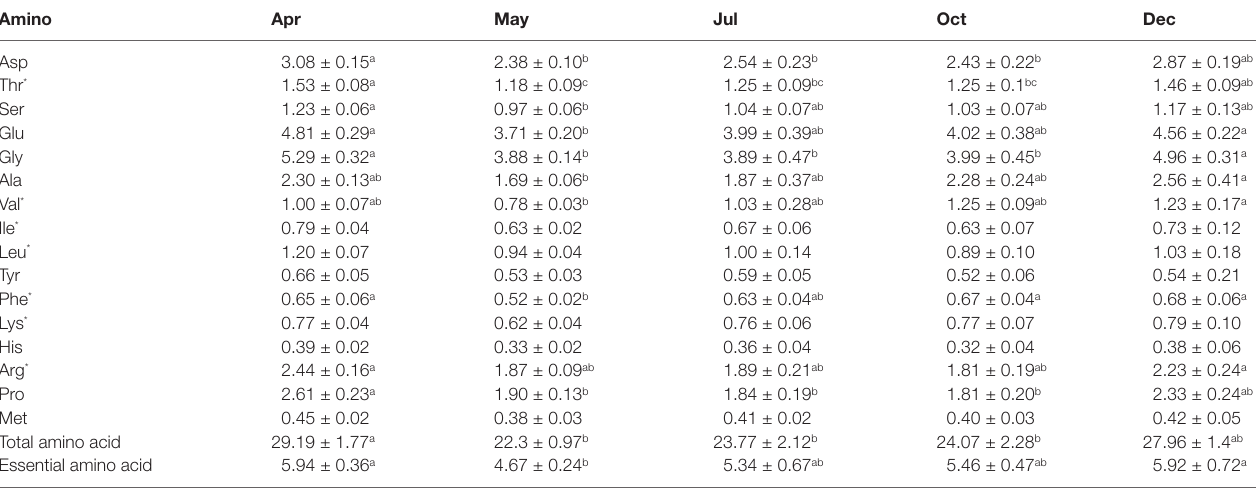
TABLE 3 | Amino acid content in body wall of Stichopus monotuberculatus in different months (g/100